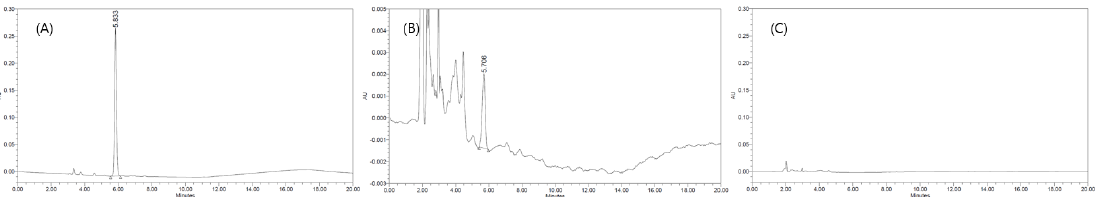
Figure 3. Chromatogram and spectrum of ethoxyquin using high-performance liquid chromatography/photodiode array (HPLC-PDA). ( A ) Ethoxyquin standard, ( B ) Ethoxyquin spiked in seasoning sample, ( C ) Blank sample. Table 2. Correlation coe ffi cients of the calibration curves, LOD and LOQ (n = 3). Matrix